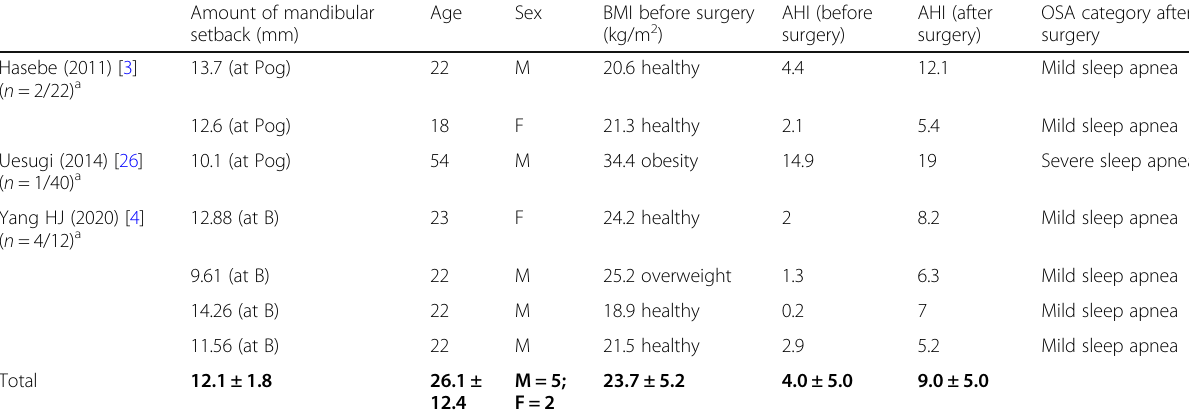
Age Sex BMI before surgery